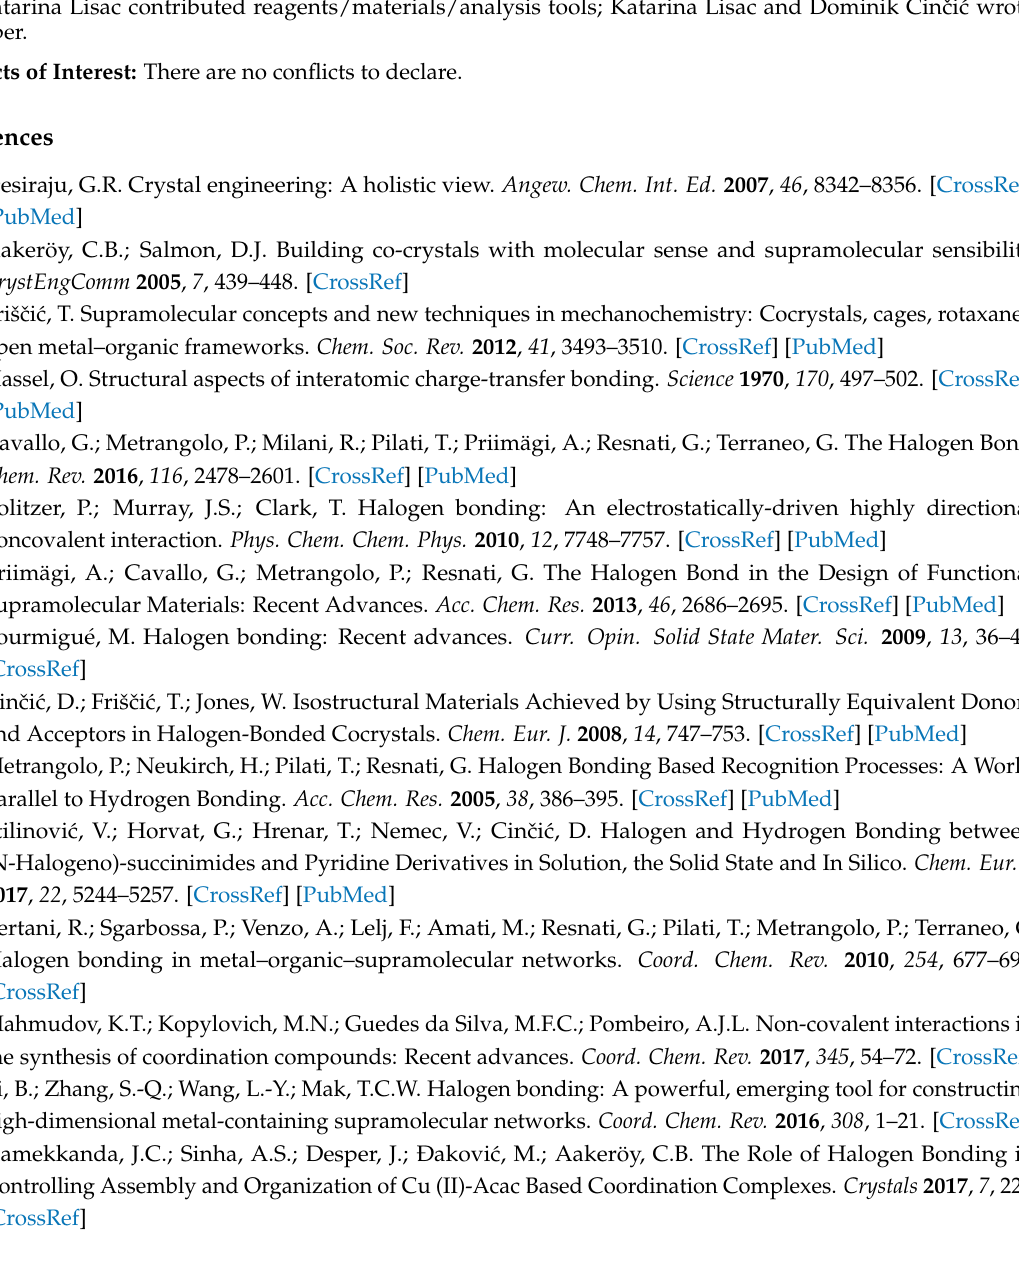
single crystal data of 1 , Figure S4: PXRD patterns of: ( a ) 1 obtained by LAG; ( b ) 1 after exposure to methanol vapor for 16 h; ( c ) calculated pattern from single crystal data of 2 ; and ( d ) calculated pattern from single crystal data of 1 , Figure S5: Molecular structure of 1 showing the atom-labeling scheme. Displacement ellipsoids are drawn at the 50% probability level and H atoms are shown as small spheres of arbitrary radius, Figure S6: Molecular structure of 2 showing the atom-labeling scheme. Displacement ellipsoids are drawn at the 50% probability level and H atoms are shown as small spheres of arbitrary radius, Table S1: Geometric parameters for the halogen bonds in 1 and 2 , Table S2: Geometric parameters for the hydrogen bonds in 1 and 2 . CCDC 1585631 and 1585632 contain crystallographic data for this paper. These data can be obtained free of charge from the Director, CCDC, 12 Union Road, Cambridge, CBZ 1EZ, UK (Fax: +44-1223-336033; email: deposit@ccdc.cam.ac.uk or